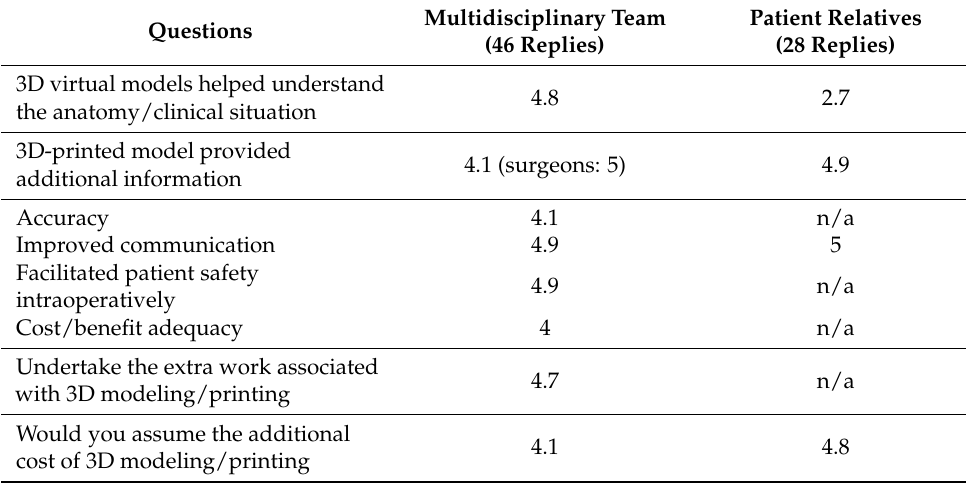
Table 3. Average values of opinions of the multidisciplinary team and patient relatives on 3D modeling based on a questionnaire survey. Range of values: 1 = strongly disagree, 2 = disagree, 3 = indifferent, 4 = agree, 5 = strongly agree; n/a: